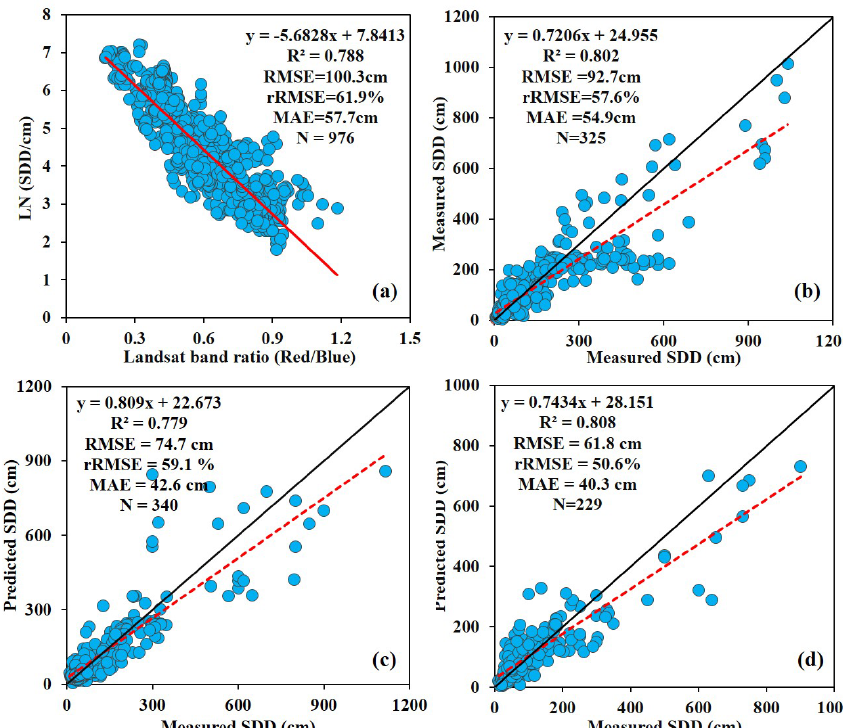
Figure 3. Model calibration and validation for SDD estimation with the Landsat TOA reflectance product acquired by different Landsat sensors: (a) model calibration with three-quarters of the total number of samples from the first dataset, (b) model validated with one- quarter of the total number of samples from the first dataset, (c) model validated with the second dataset independently collected during the limnological survey (2007–2009) and (d) model validated with the third dataset collected in the first lake environmental survey during